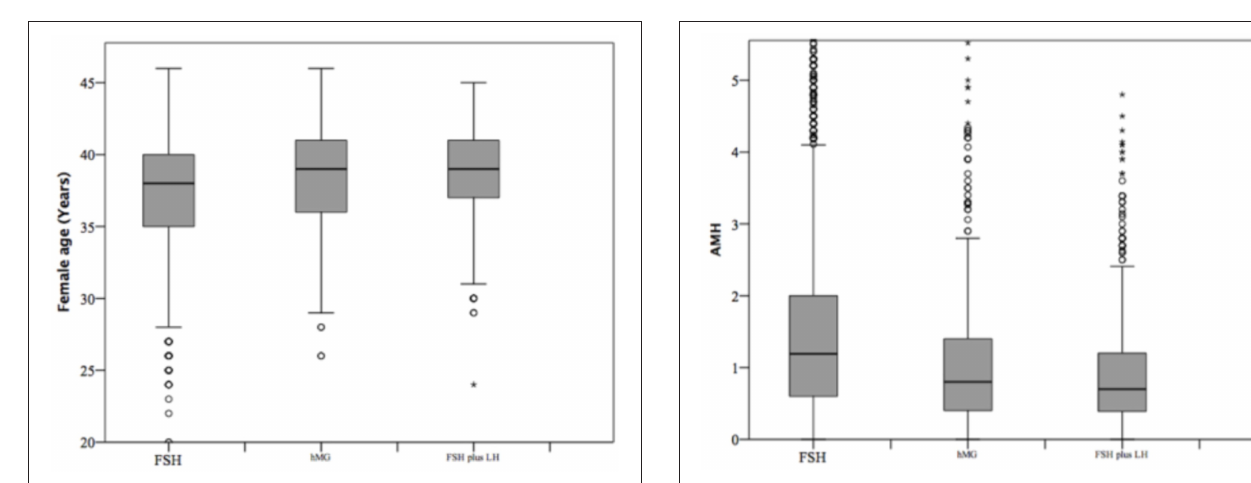
number of MII oocytes reflected the total oocytes number, with a higher retrievement in group 1 compared to groups 2 and 3 ( p < 0.001 and p < 0.001) and a similar number between groups 2 and 3 ( p = 0.620). Interestingly, the MII oocytes on total oocytes retrieved ratio was not different among groups ( Table 1 ). Again, similar trend was observed for injected and fertilized oocytes ( Table 1 ). Despite the differences between group 1 and other groups, the number of cumulative, transferred and frozen embryos did not differ among groups ( Table 1 ), suggesting that the addition of LH improve the oocytes quality and capability to develop embryos.